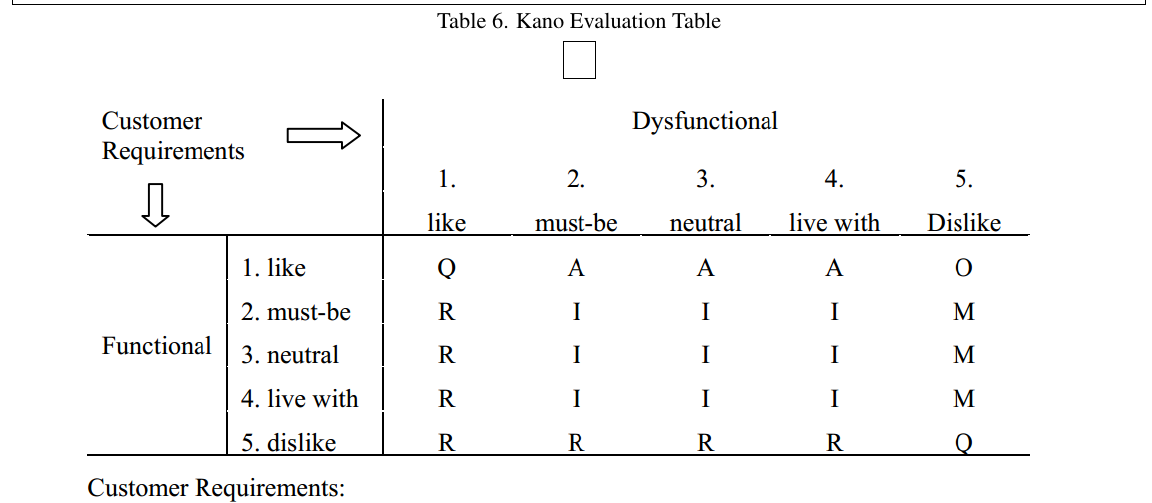
Table 6. Kano Evaluation